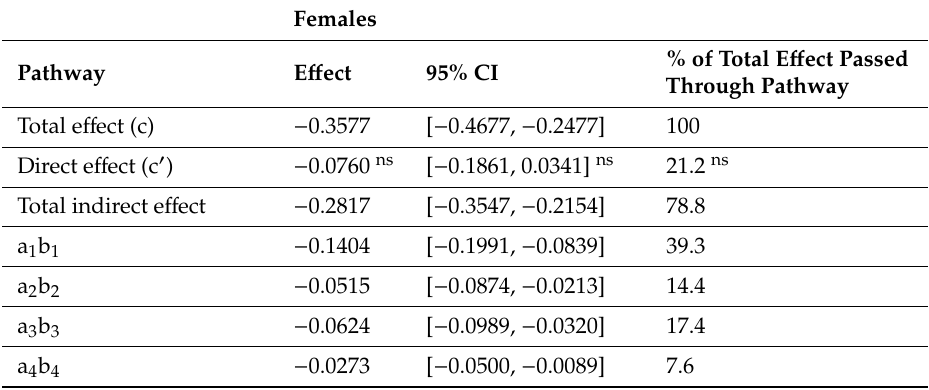
Table A4. Direct and indirect e ff ects for mediating pathways for females of the relationship between stress in 2012 and work ability in 2017 in a parallel design ( n =